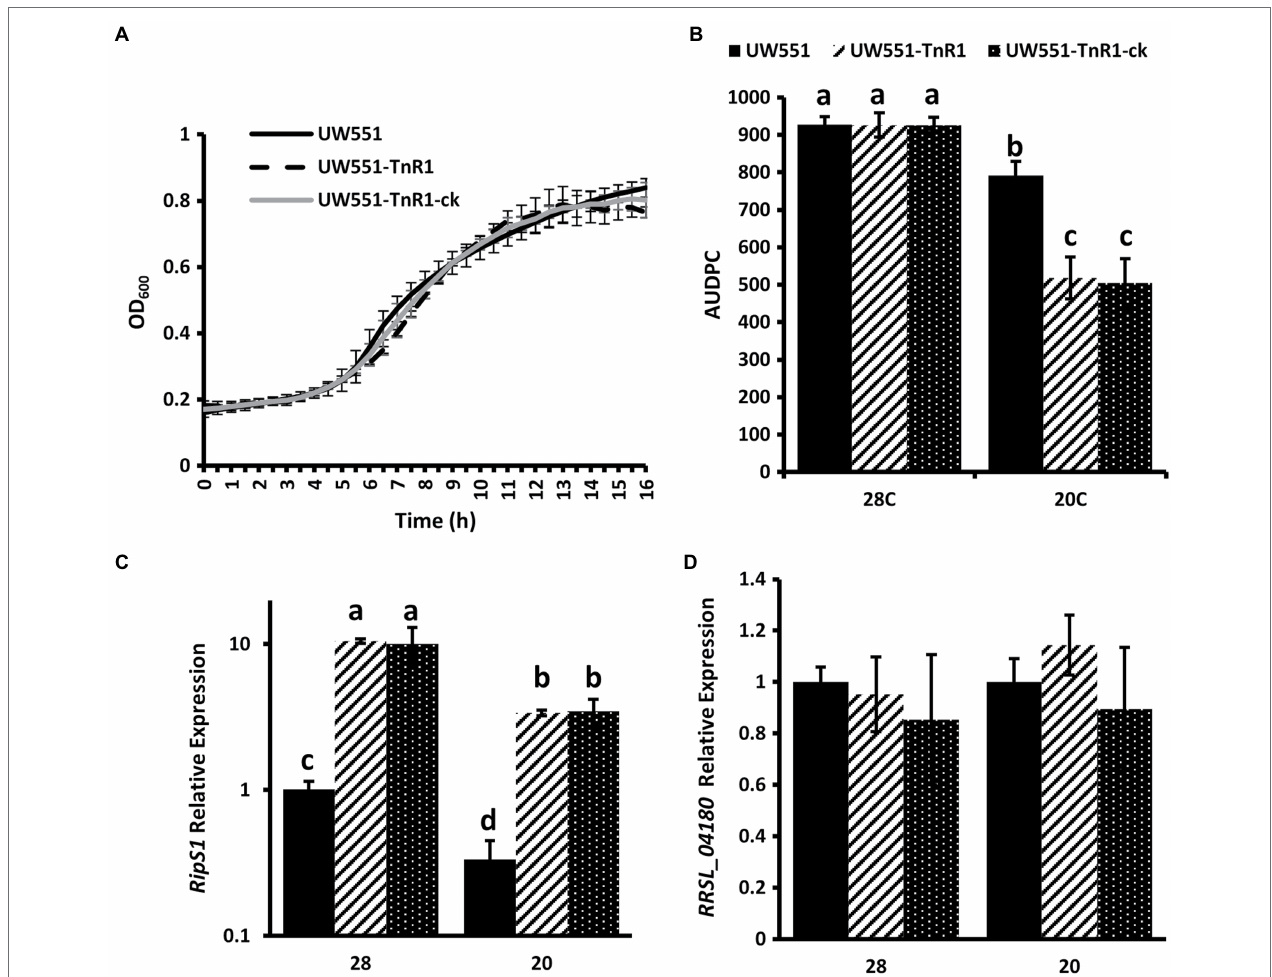
FIGURE 3 | Independent mutant UW551-TnR1-ck confirms phenotypes of random transposon mutant UW551-TnR1. No significant differences observed in growth in CPG medium (A) . Area under the disease progress curve (AUDPC) for virulence assays in tomato seedling assays shows no difference between transposon mutant UW551-TnR1 and independent mutant UW551-TnR1-ck, as compared to the wild-type strain UW551 (B) . Similar relative mRNA abundance of ripS1 (C) or RRSL_04180 (D) in transposon mutant UW551-TnR1 and independent mutant UW551-TnR1-ck, as compared to the wild-type strain UW551. cDNA from RNA isolated from bacterial cells grown for 24 h in CPG medium at the indicated temperature served as template for qRT-PCR reactions. Three independent samples were collected for each strain-growth combination, and each sample was tested in triplicate. Values represent average of all samples and error bars represent SD. Samples with different letters are significantly different ( p < 0.05, Student’s t -test, all